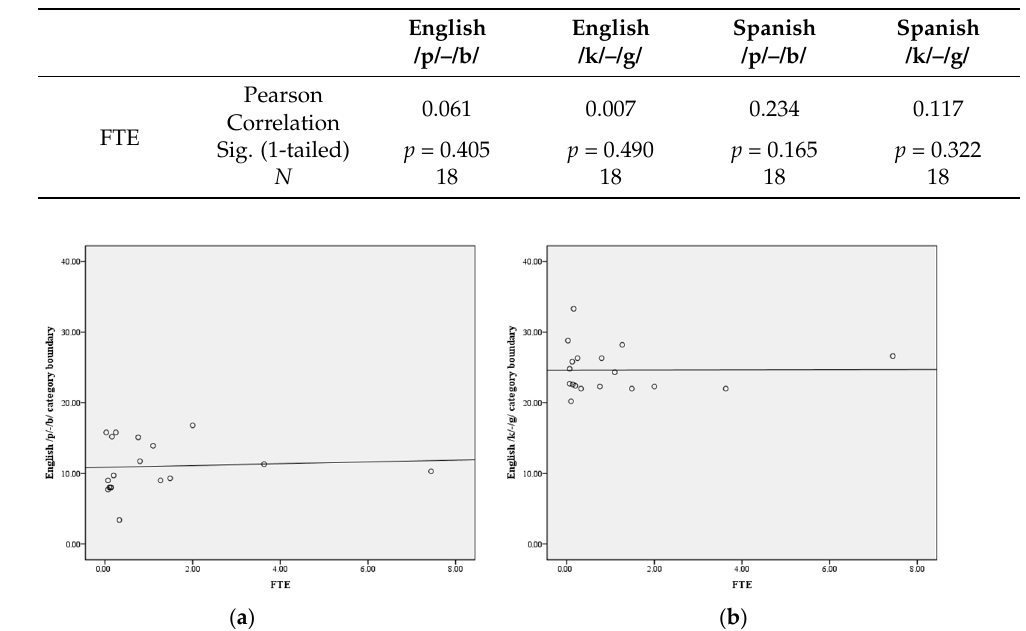
Table 5. Results for the correlation tests between FTE and category boundaries for the Spanish learners of English.